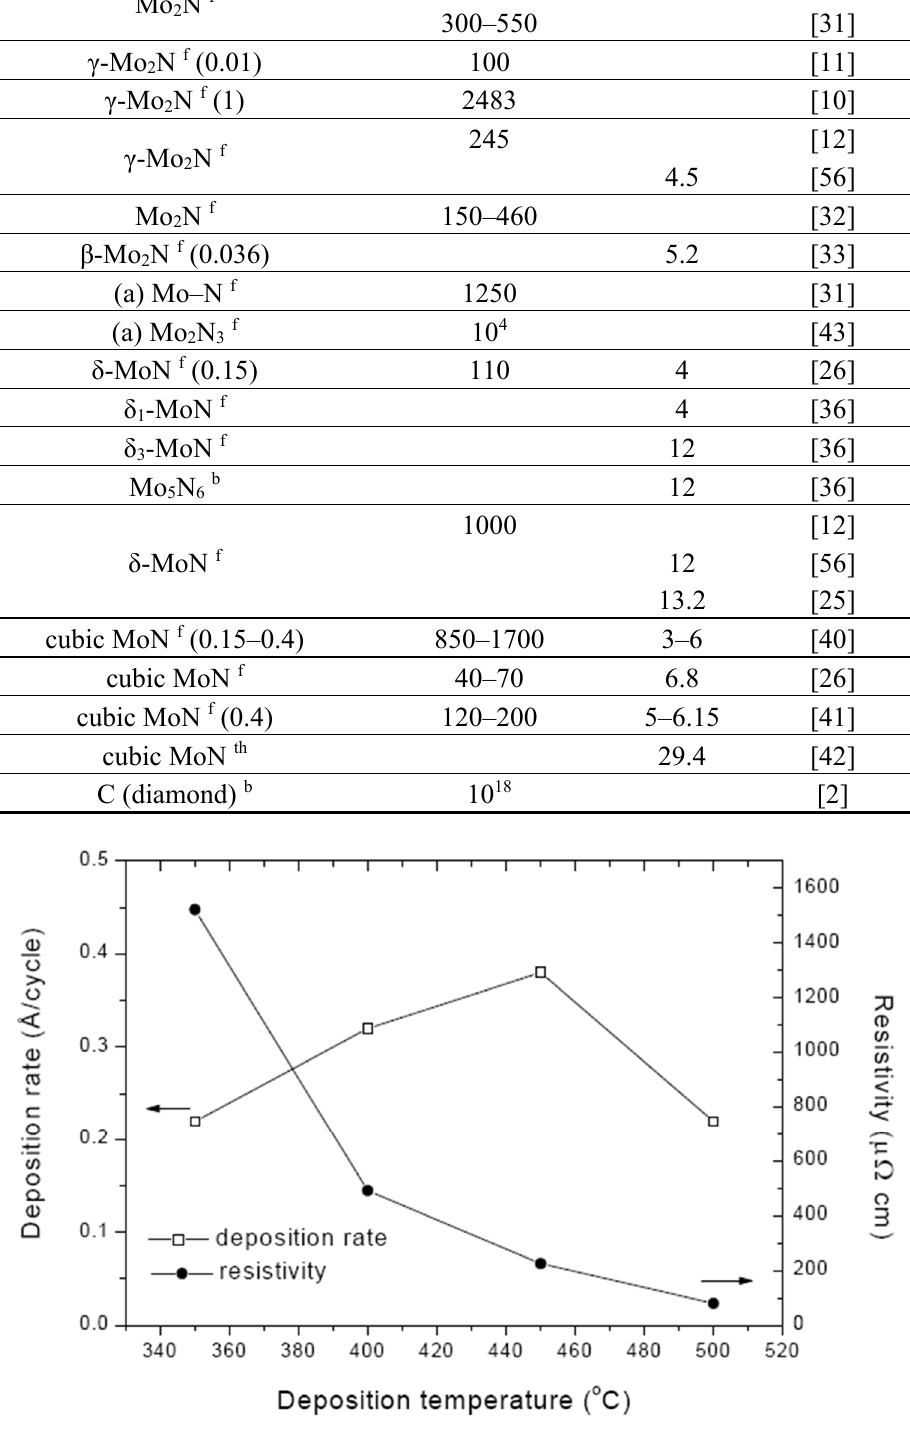
Figure 4. Deposition rates and resistivities of MoN x films as a function of deposition temperature (according to Alen, Ph.D. thesis, 2005